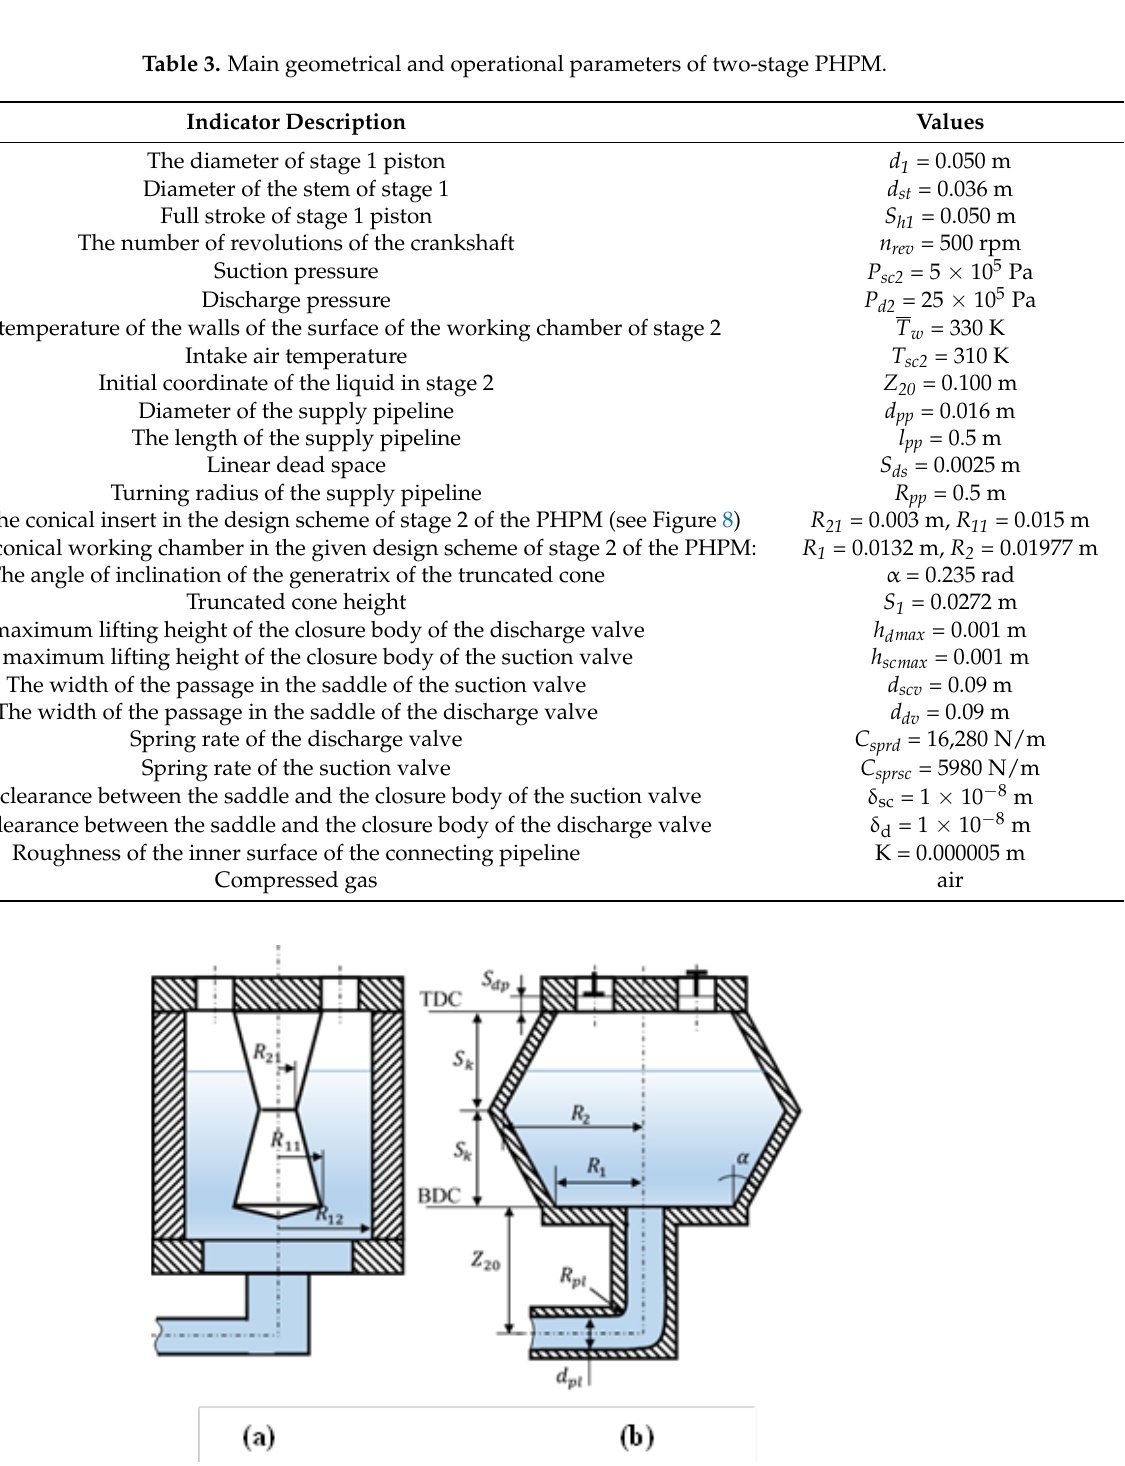
Figure 8. Two-stage piston hybrid power machine with a profiled working chamber: ( a ) objective design diagram of PHPM stage 2; ( b ) given design diagram of PHPM stage 2.